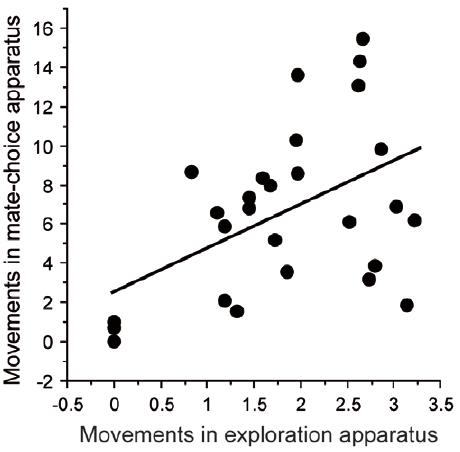
Figure 2. Influence of exploration tendencies on the number of movements performed during mate-choice trials. Both scales have been transformed to reach normality.